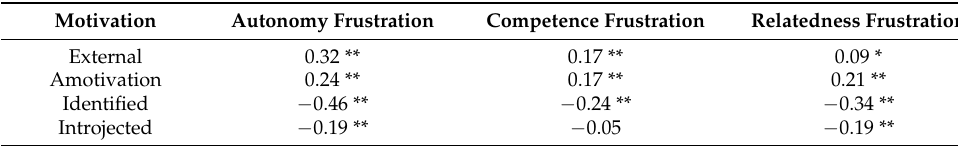
Table 6. Correlations between need frustration and